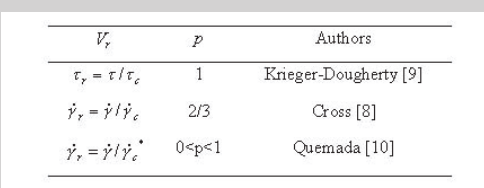
Table 2: Phenomenologi- cal parameters of Krieger-Dougherty, Cross and Quemada models.